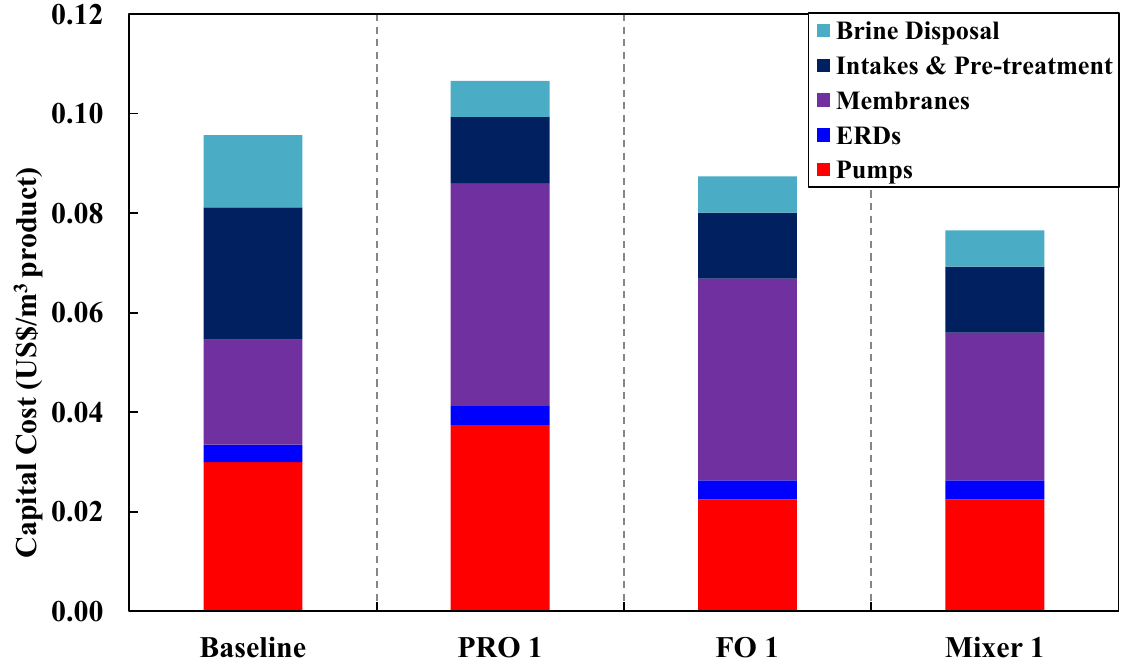
Figure 11. A summary of the capital costs for the various configurations.